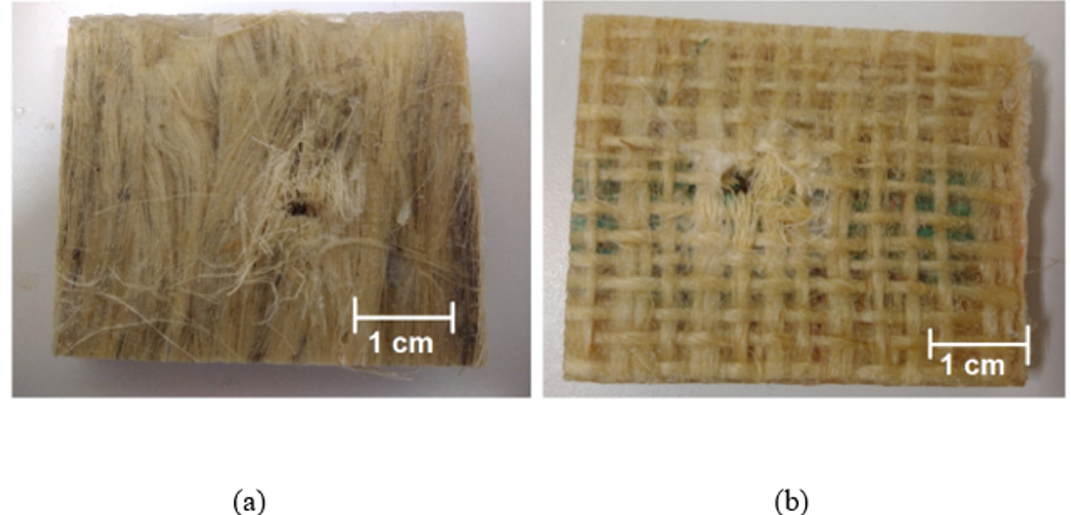
Figure 5. Samples subjected to ballistic impact: (a) fique fiber and (b) fique fabric.